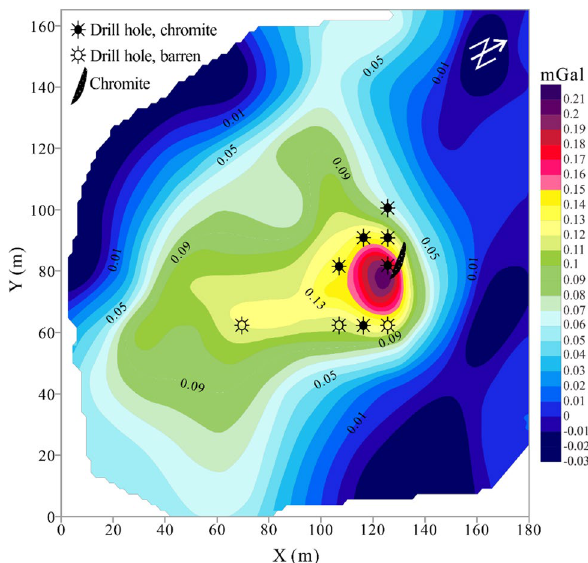
Fig. 7 Example of the gravity exploration technique (modified